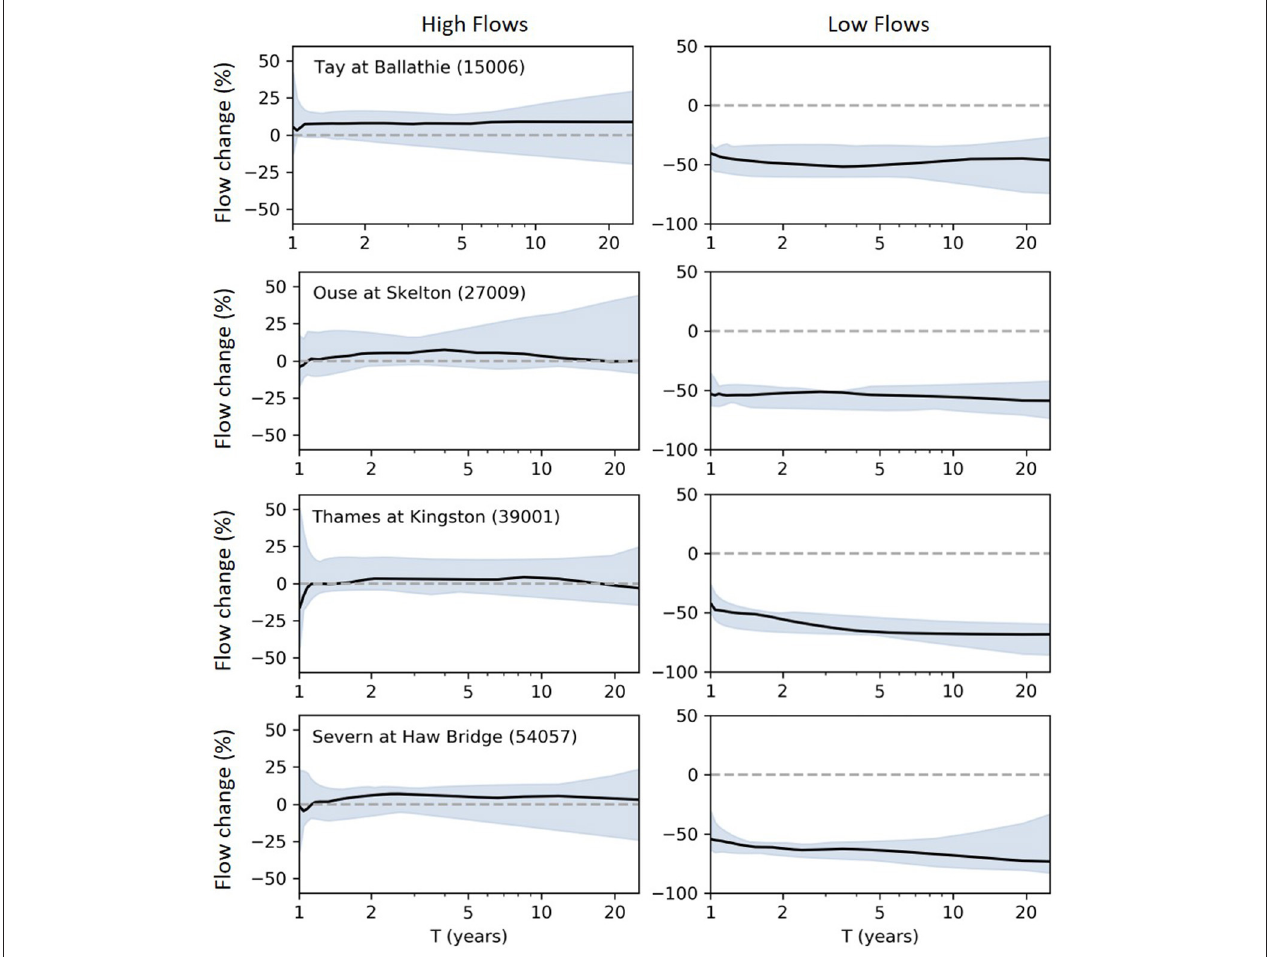
FIGURE 3 | Change in flow frequency curves for high flows (left) and low flows (right) at the four example catchments. These show the percentage change between baseline and future flows for different return periods. The shaded area shows the second lowest to second highest change between the 12 ensemble members, whilst the solid line shows the